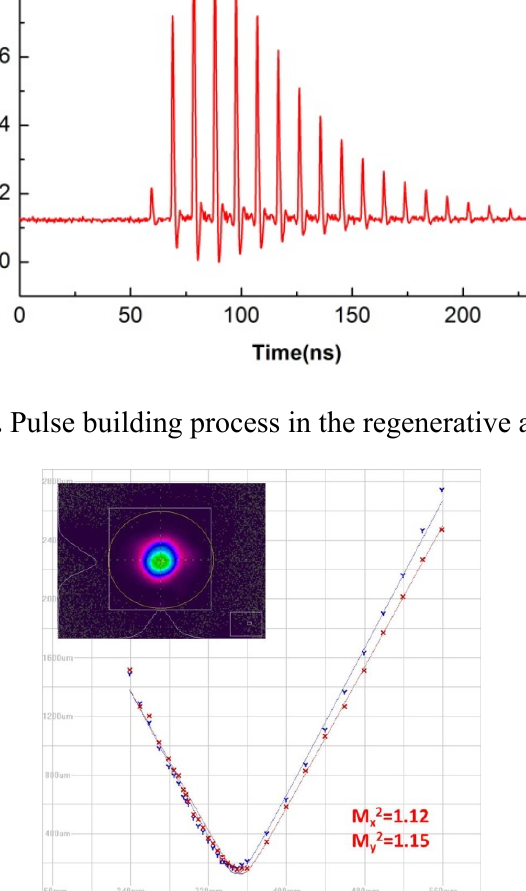
Figure 6. The beam quality of the output pulses from the regenerative